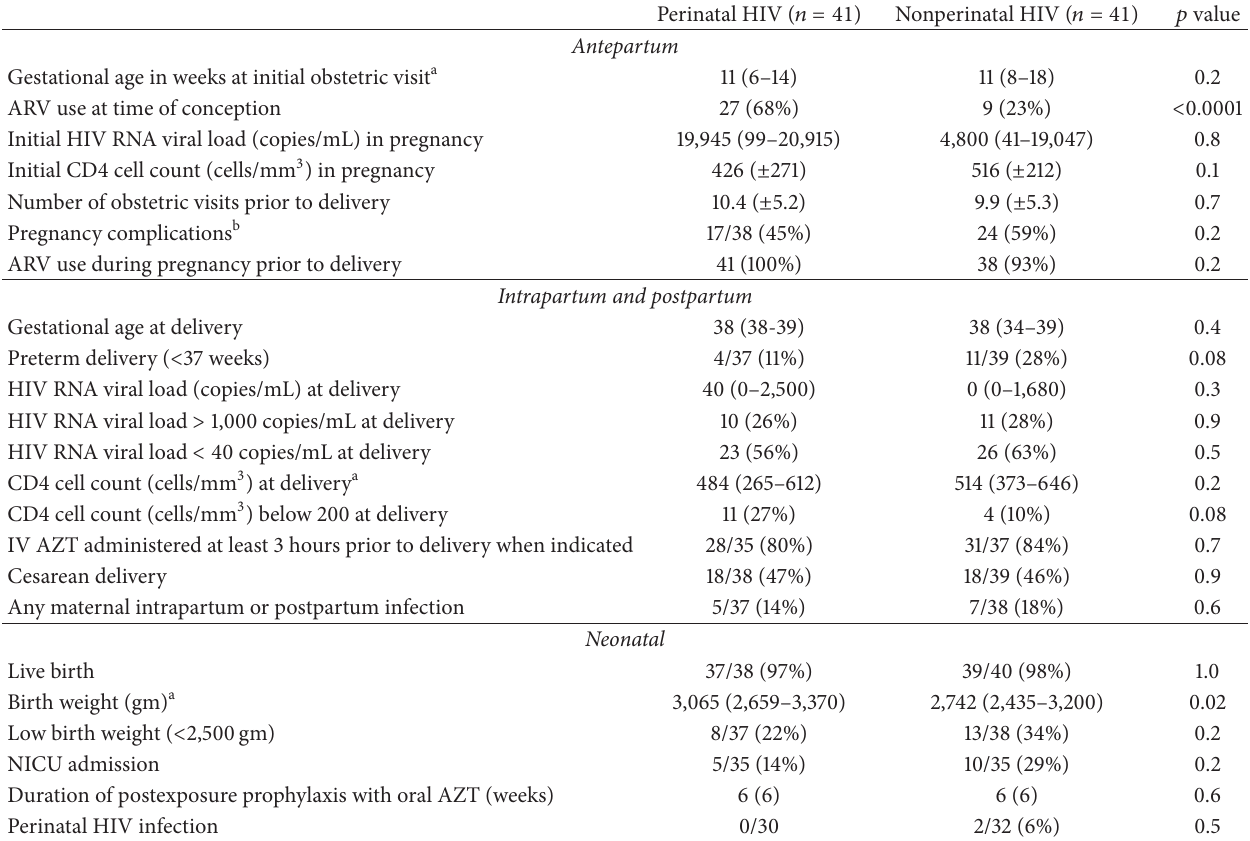
Table 2: Antepartum, intrapartum, and neonatal findings among pregnant women with perinatal HIV and nonperinatal HIV